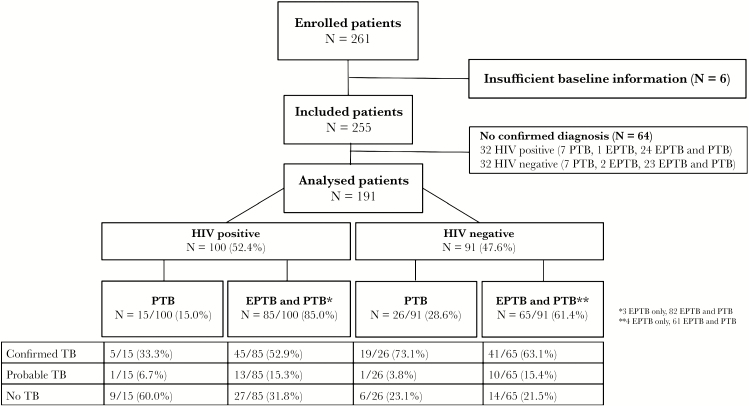
Enrollment of patients. Patients are presented according human immunodeficiency virus (HIV) status and final diagnosis reached. No confirmed diagnosis, no confirmed tuberculosis (TB) at inclusion, and lost to follow-up; confirmed TB, microbiologically confirmed TB; PTB, pulmonary tuberculosis; EPTB, extrapulmonary tuberculosis; EPTB and PTB, presence of EPTB and PTB in a patient.